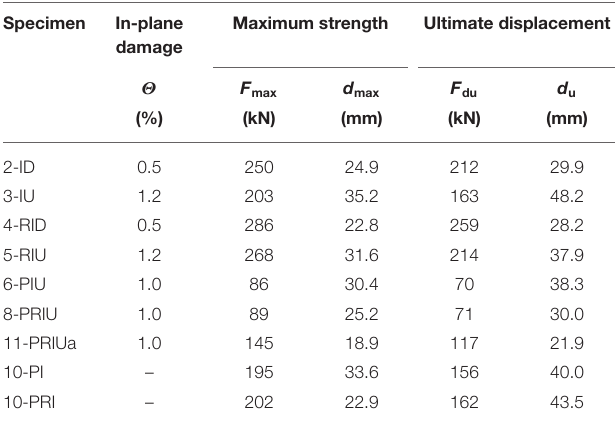
TABLE 5 | Out-of-plane test